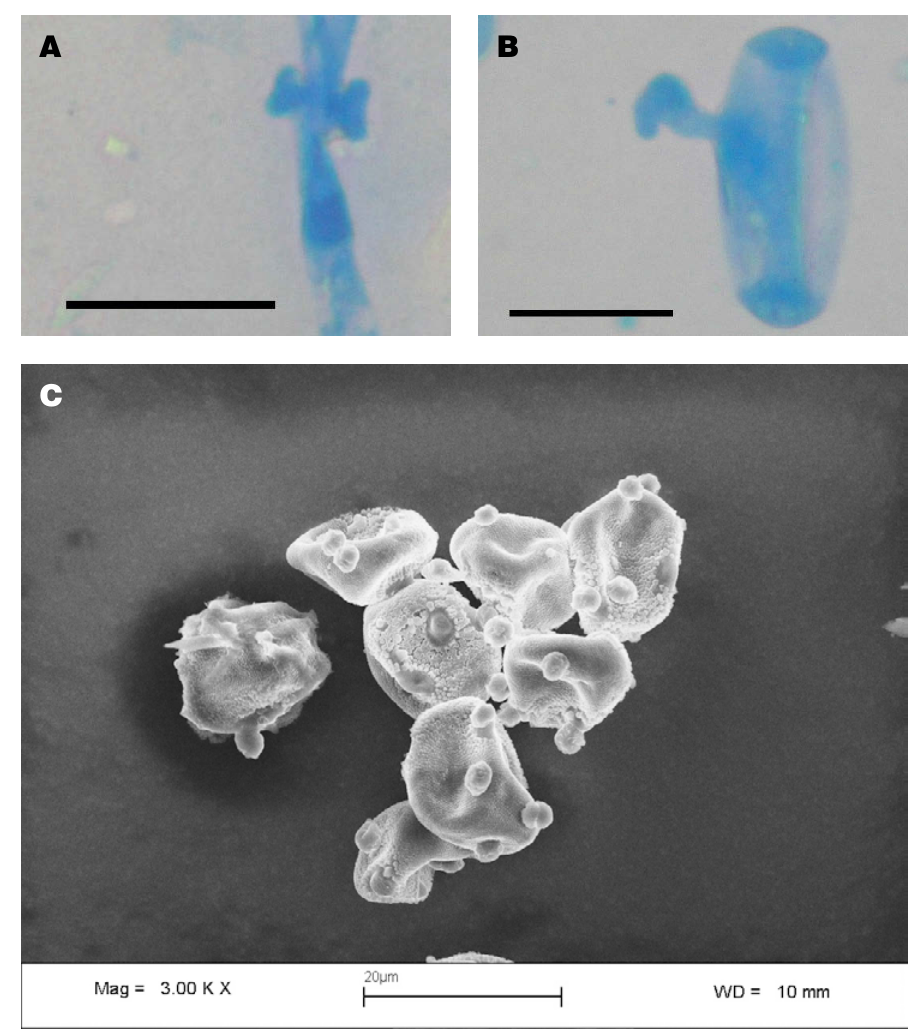
Fig. 1. A – lobed appressoria of Neoerysiphe galeopsidis ; B – germinating conidium of Neoerysiphe galeopsidis ; C – aeciospores of Puccinia mei-mamillata on Angelica sylvestris , scale bar = 20